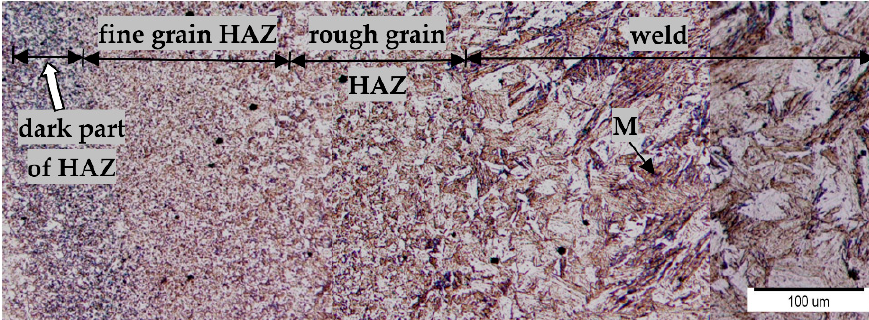
Figure 10. Microstructure of the weld and HAZ obtained at welding speed of 0.8 m/min.